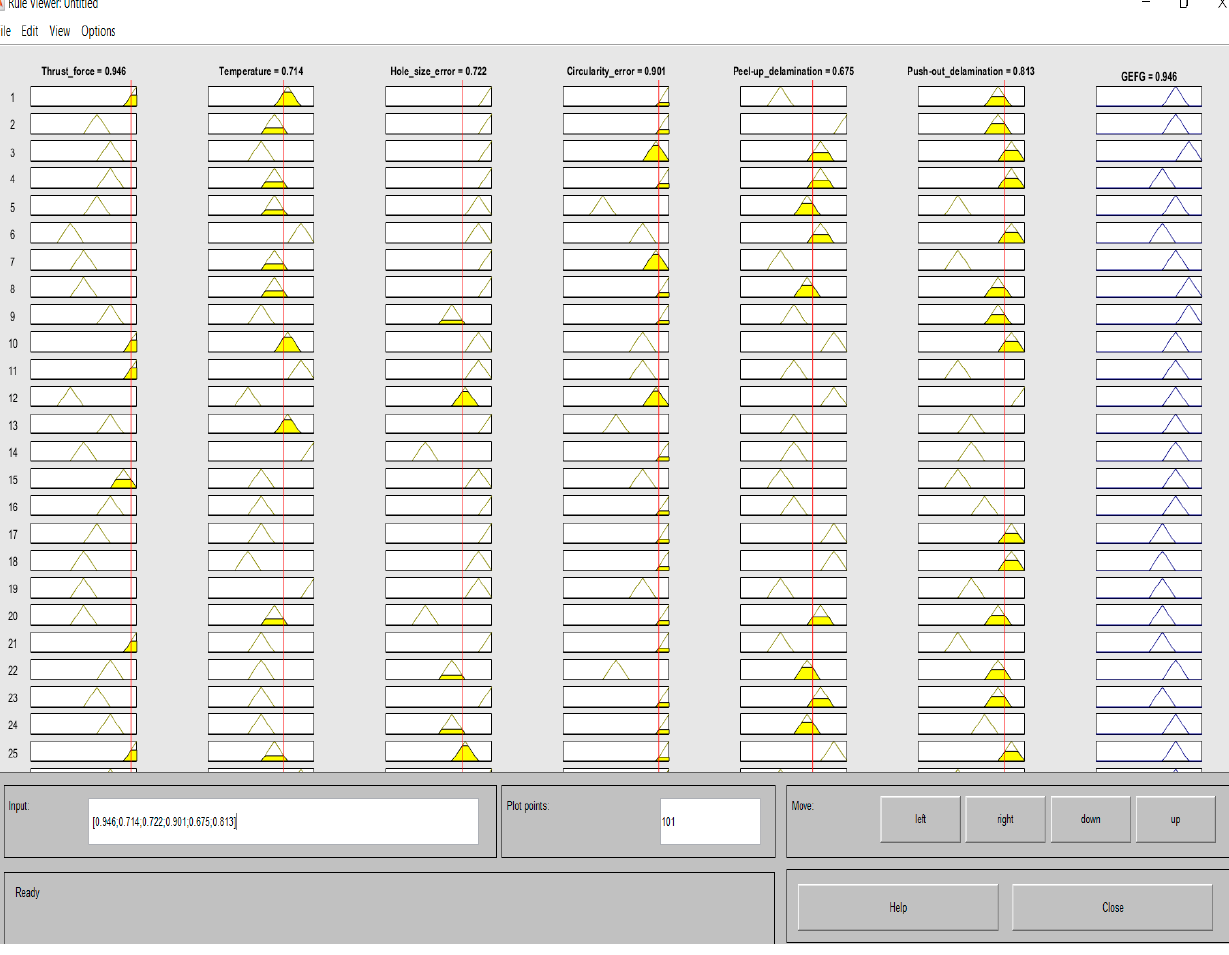
Figure 7. Fuzzy logic rule viewer of Experiment Number 2 (highest GEFG). Table 8. Grey Relational Coefficients, Grey Relational Grade and Grey Entropy Fuzzy Grade (GEFG).